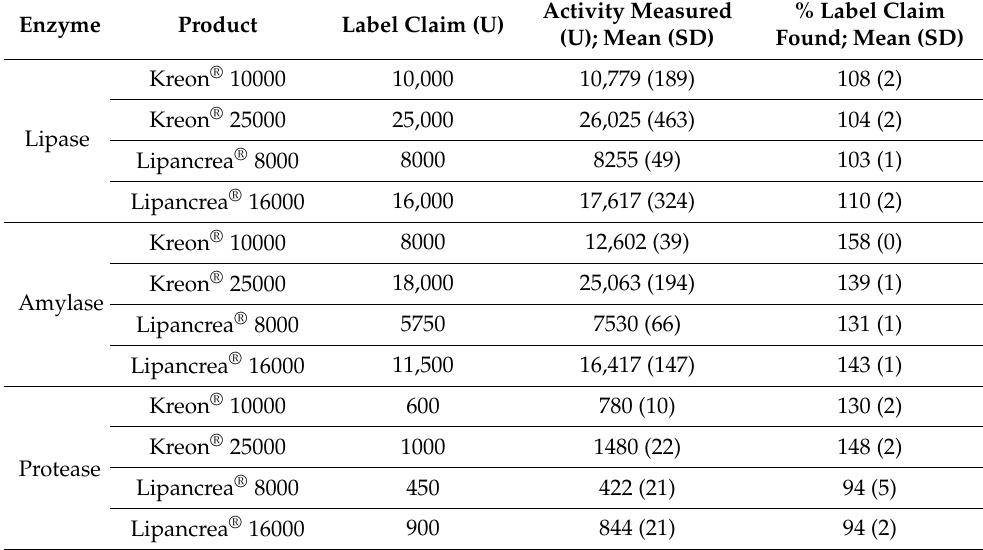
Table 3. Comparison of lipase, amylase and protease activity to label claim.